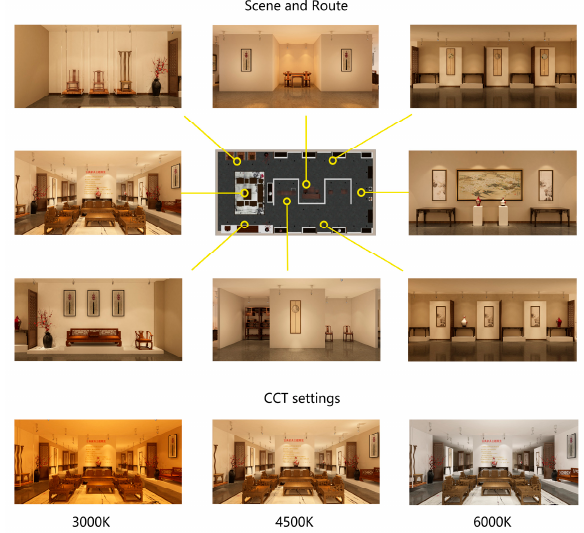
Figure 2. Virtual reality exhibition.